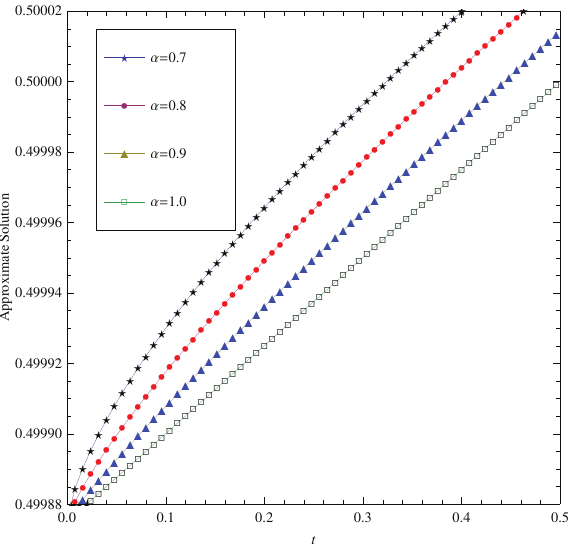
Fig. 2: Plot of u 3 ( x , t ) vs. time t at x = 1 and different value of α .